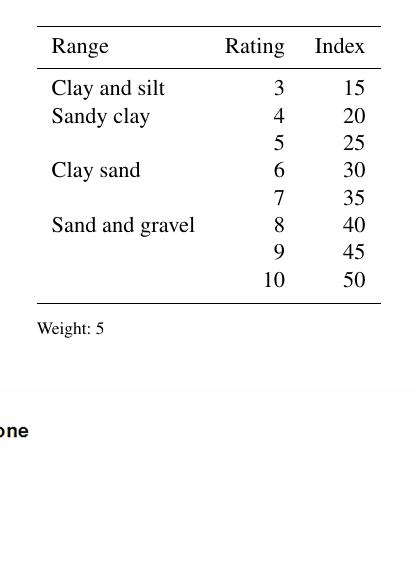
Table 7. Range and rating for hydraulic conductivity.